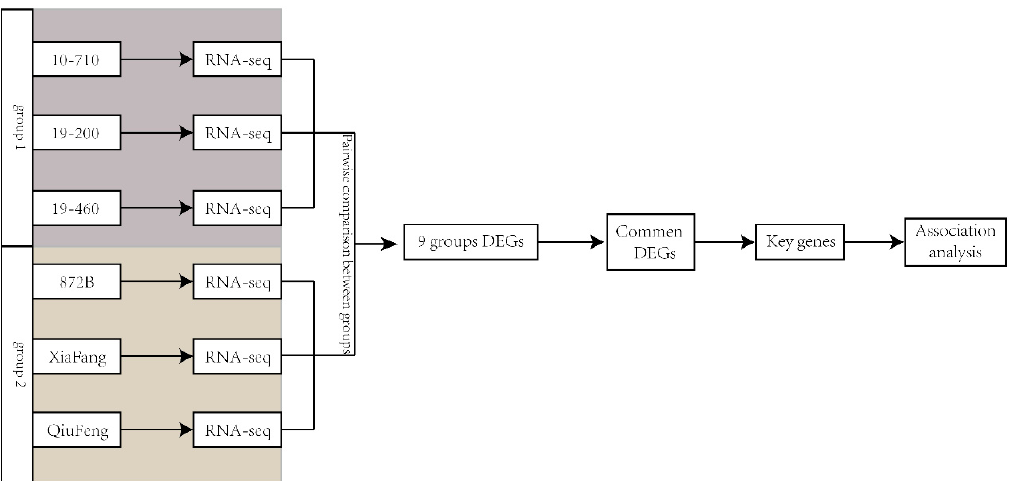
Figure 3. Experimental comparison strategy design. By comparing the three high-yield strains with the three low-yield strains, nine groups of DEGs were obtained. Differentially expressed in more than four of the nine groups of DEGs were defined as common DEGs. The key genes were obtained by screening the common DEGs through quantitative detection of each strain in silk glands. Finally, the association analysis with the cocoon shell weight (CSW) was conducted in key genes.